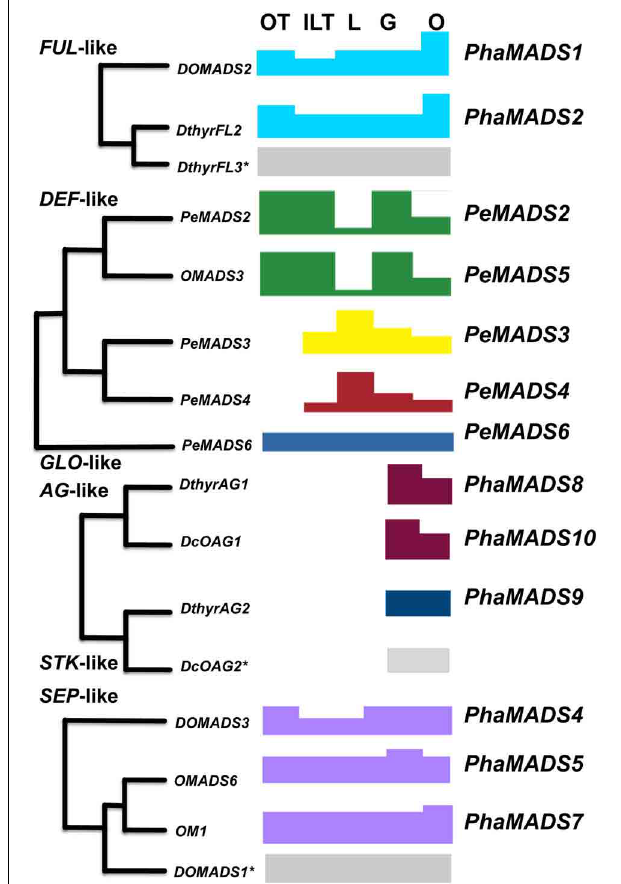
FIGURE 9 | A transcriptional model for Phalaenopsis flower development. Summary of expression patterns of orchid paralogous FUL -, DEF -, GLO -, AG -, STK -, and SEP -like genes in Phalaenopsis perianth and reproductive organs. The combined differential activity and levels of expression of genes from different clades in each organ are represented with blocks of different colors and mapped on their domains of expression in the perianth, column and ovary. Genes corresponding to a clade with an asterisk were isolated and measured in other studies and their pattern of expression is included here for